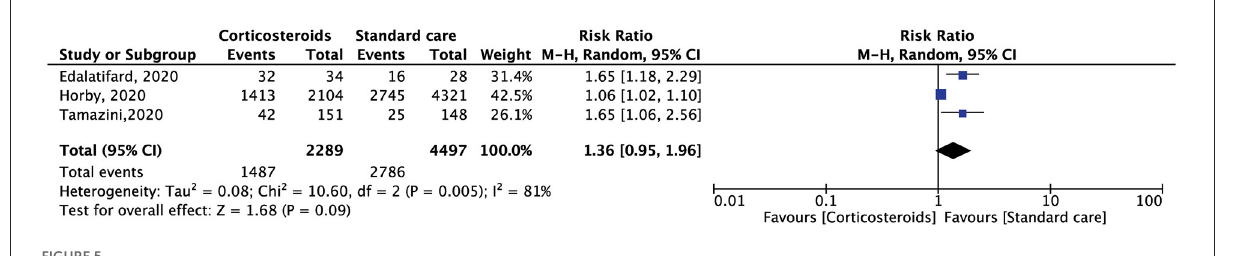
FIGURE5 Forest plot of comparison: hospital discharge